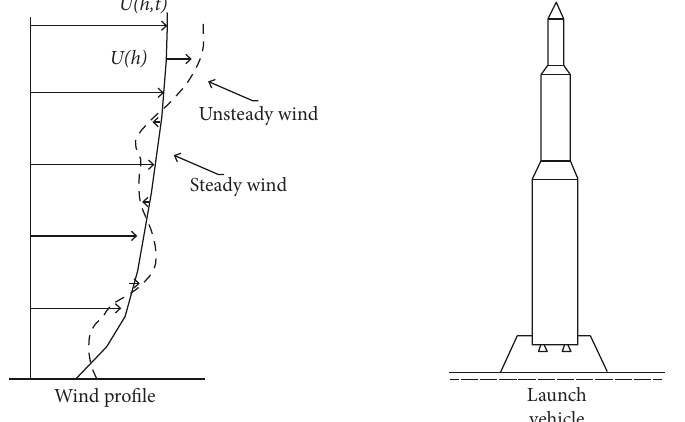
Figure 1. Launch vehicle exposed to steady state (mean) and unsteady component for ground winds (Geissler, 1970). superposed (Geissler 1970). The second-order loads resulting from the interaction of the static and dynamic wind components can be neglected in the present state of the